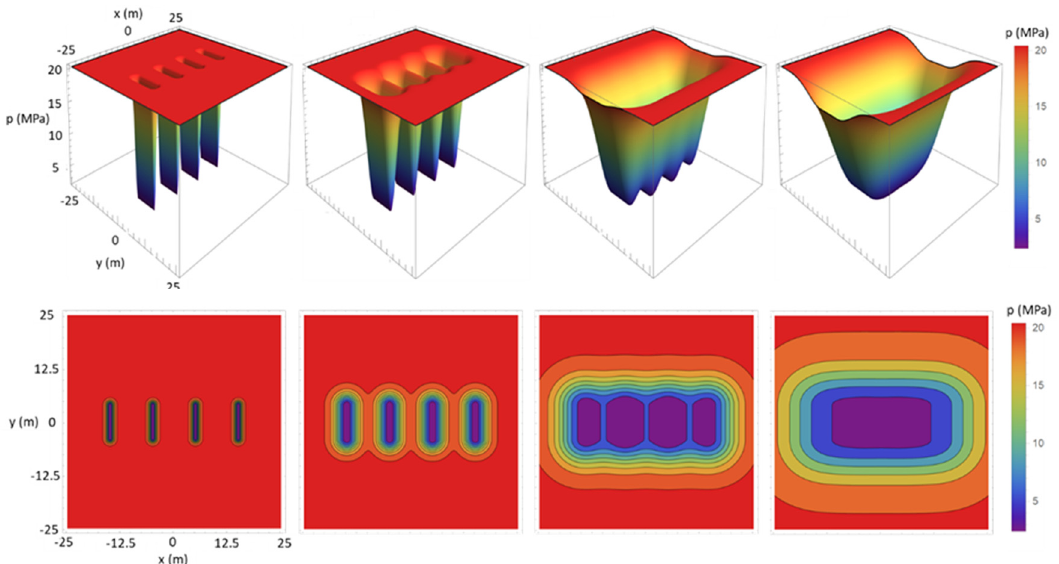
Figure 7. Example of Gaussian pressure profiles (for one treatment stage with fuour hydraulic fractures) at different times (from left to right): t = 100 h (4.2 days), 1000 h (1.4 months), 5000 h (6.8 months) and 10,000 h (1.14 years) of production. Pressure in target zone is seen in 3D (top row) and in map views (bottom row) and well is at y = 0, centrally transverse to the fractures. Vertical scale in 3D views gives pressure (in MPa). Fracture half-length is 10m and fracture spacing is 10m. P ~20 MPa and P Δ = − 13 MPa. After Wang and Weijermars [28].